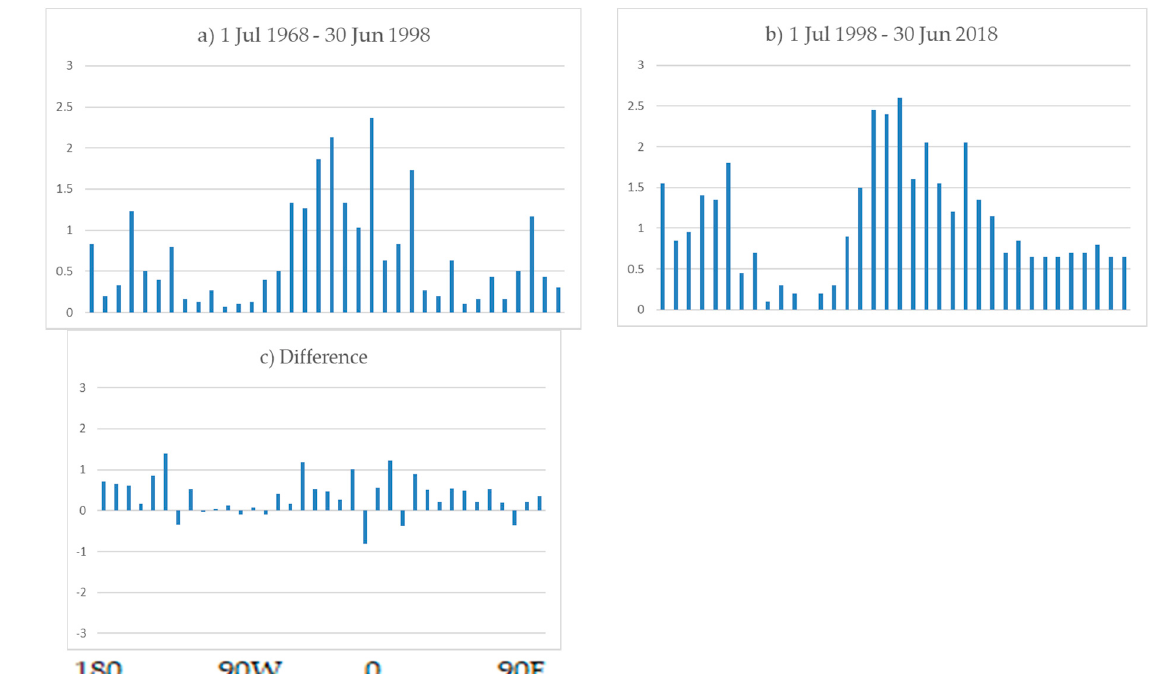
Figure 1. The number of block onsets per year versus longitude where the left-hand side begins with 180° longitude for the ( a ) [1] study, ( b ) the current study period, and ( c ) the difference between ( b ) and ( a ).